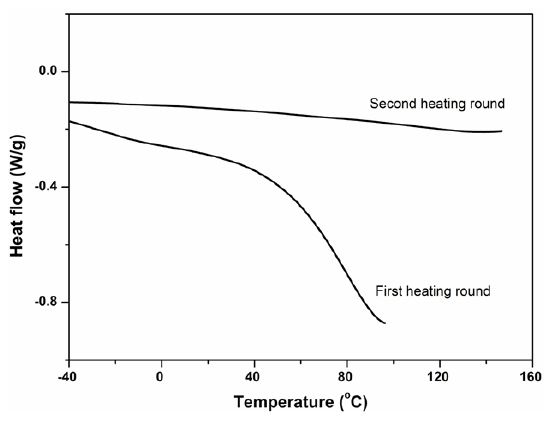
Figure 3. DSC curve of PBMAP